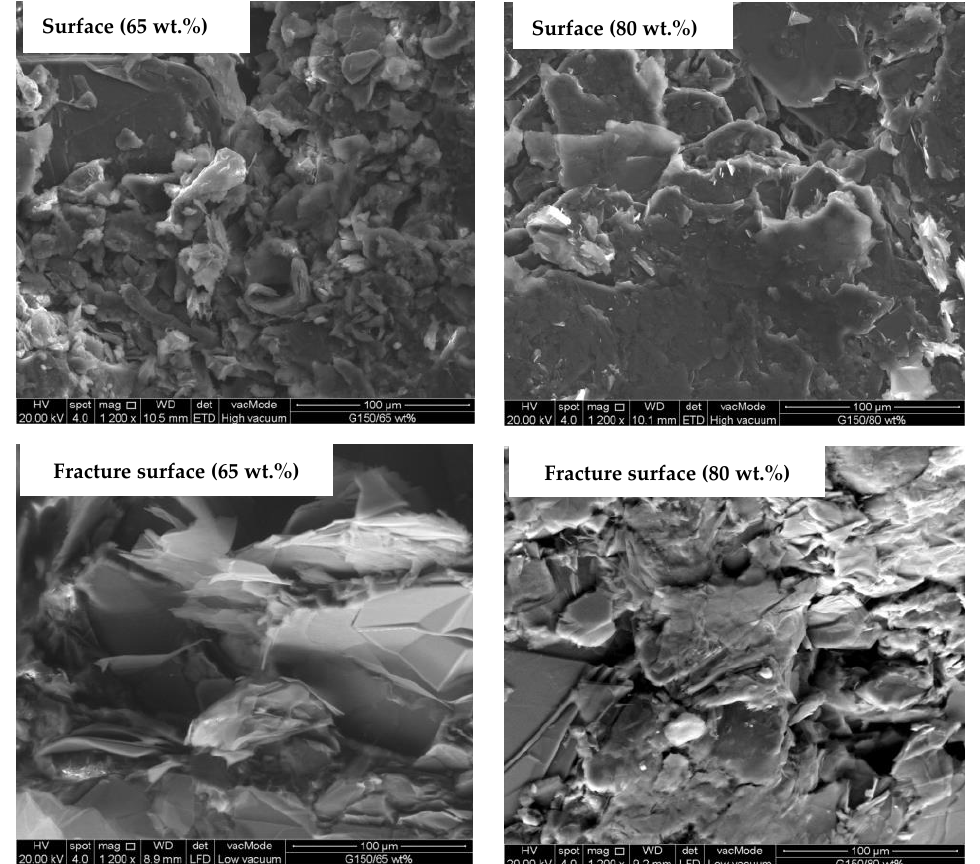
Figure 2. In-plane electrical conductivity values of the epoxy/G composites with different G particle sizes and contents: ( a ) epoxy/G150 and ( b ) epoxy/G150/G75 and epoxy/G150/G44 prepared at 110 °C for 60 min.